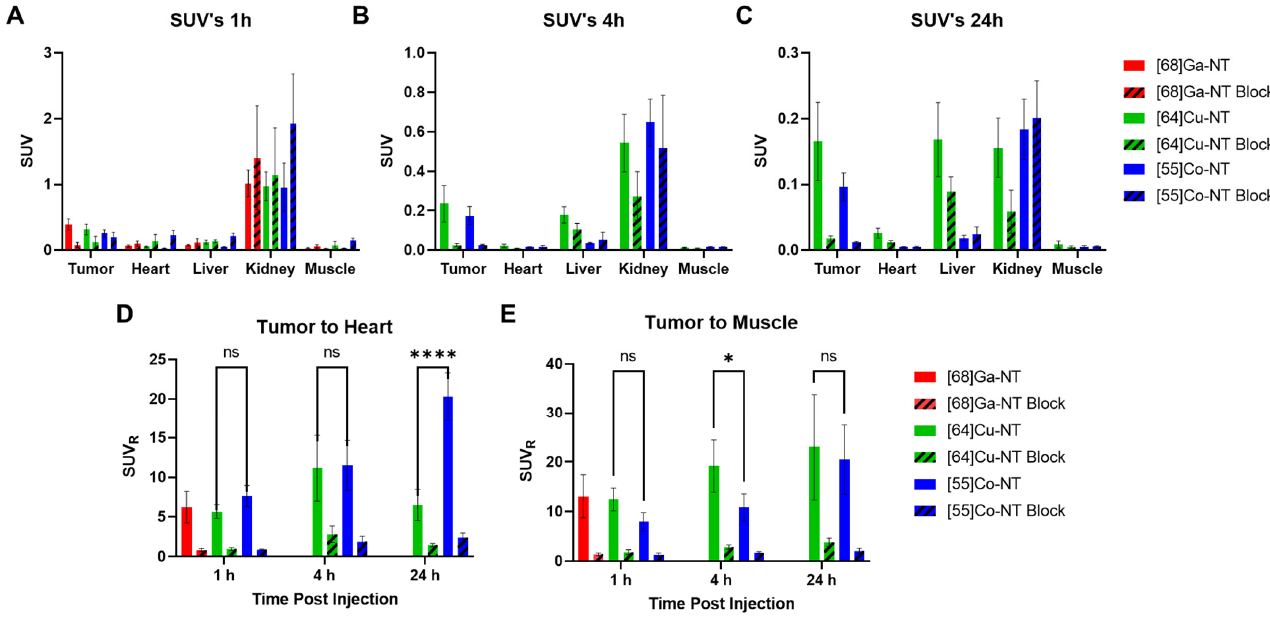
Figure 6. SUV data extracted from the PET/CT images. SUVs were extracted for selected tissues at 1 h ( A ), 4 h ( B ), and 24 h ( C ) post-injection. SUV ratio information was calculated to present tumor to heart ratios ( D ) and tumor to muscle ratios ( E ). ns: not significant, * p < 0.05, **** p < 0.0001.